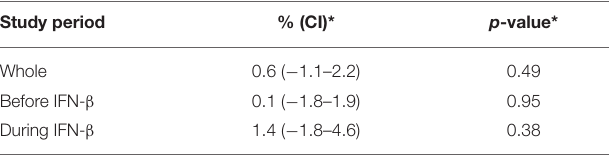
level was in February [mean (SD) 43.5 (27.7) pg/mL] and at the bottom level in September [mean (SD) 28.9 (11.6) pg/mL].